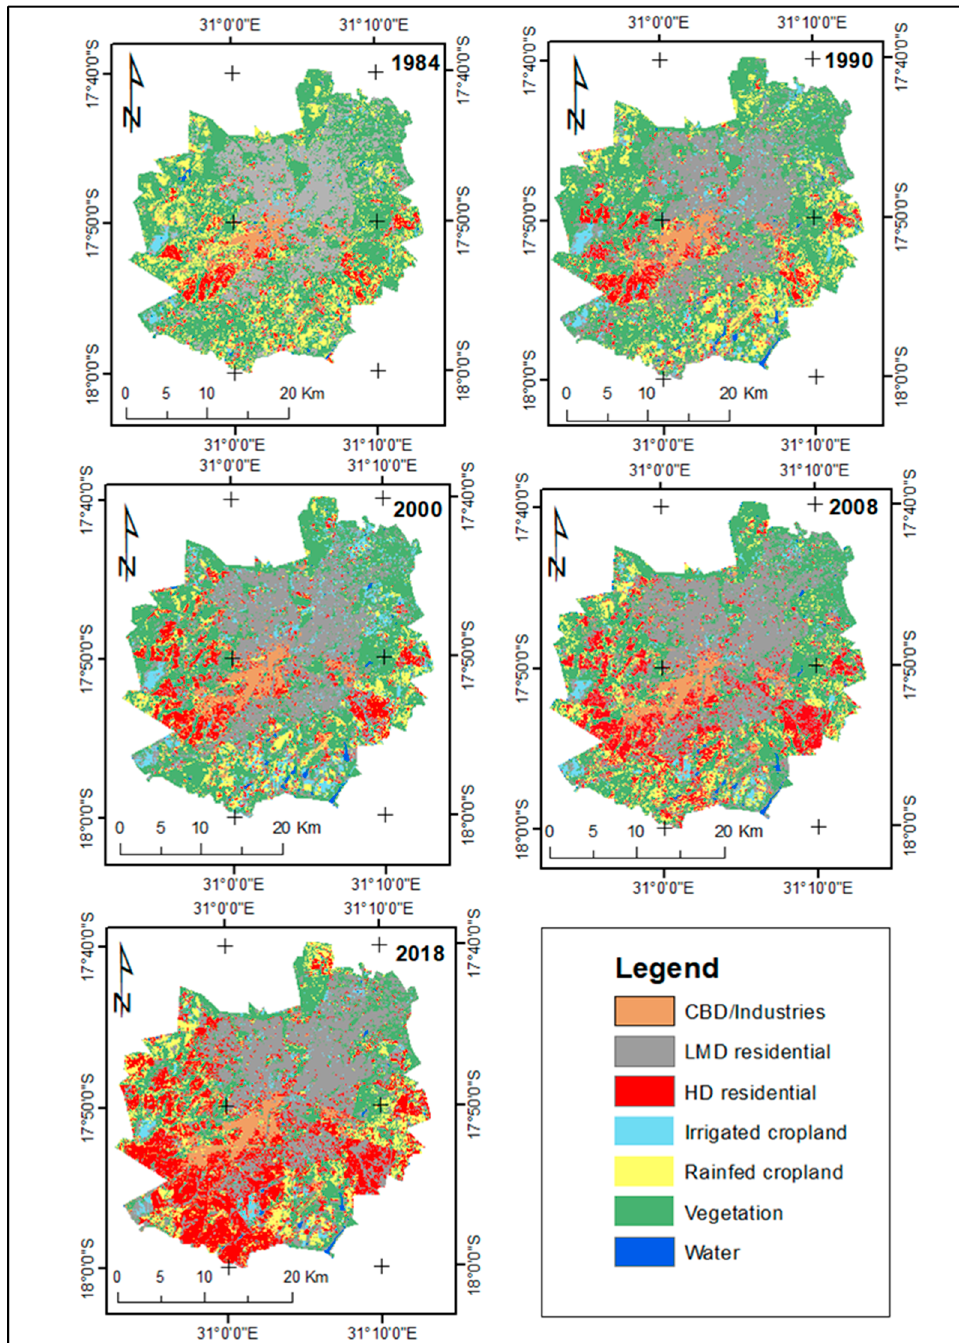
Figure 4. Land use and land cover in the Harare Metropolitan Province for the years 1984, 1990, 2000, 2008 and 2008 and 2018.